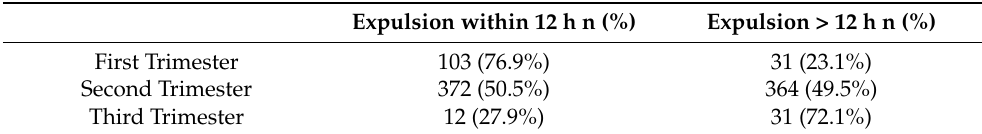
Table 2. Interval between induction of labor and fetal expulsion depending on the pregnancy trimester. Expulsion within 12 h n (%)